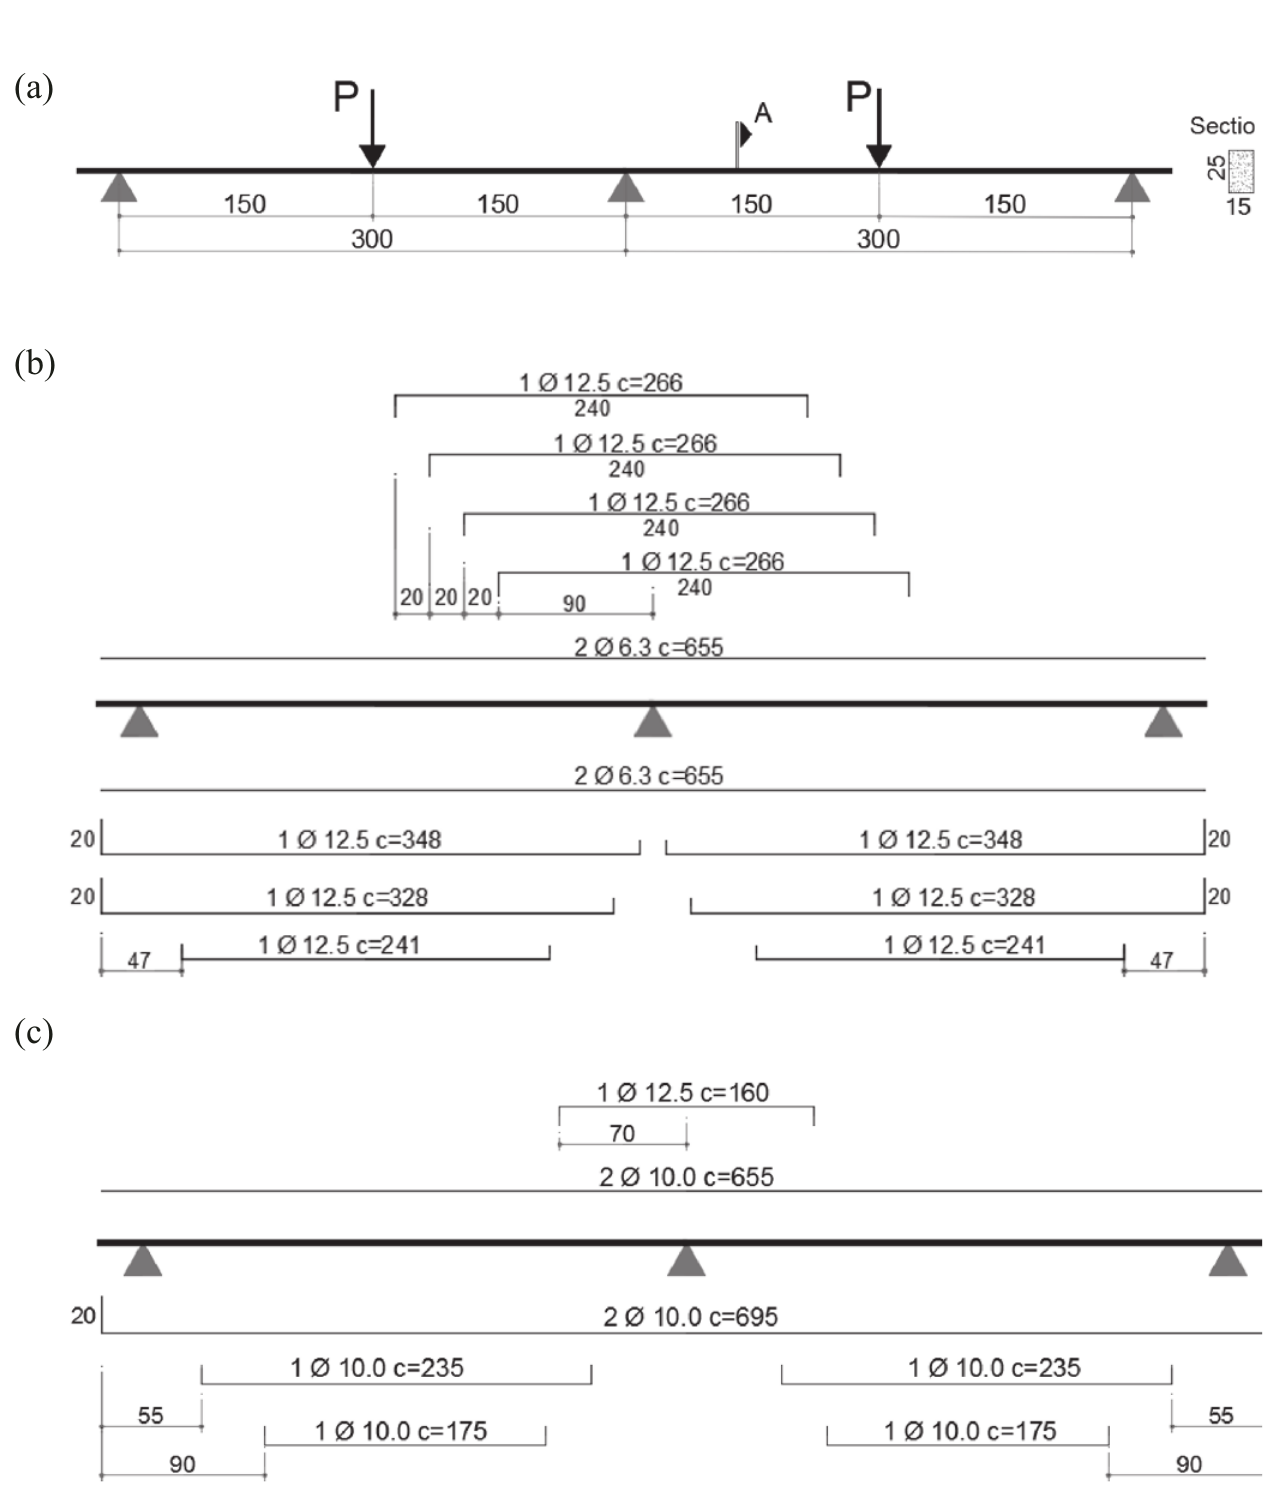
Beams tested by Silva [15]: a) geometry and loading pattern; b) longitudinal reinforcement detailing for beam V1; c) longitudinal reinforcement detailing for beam V3 (dimensions in